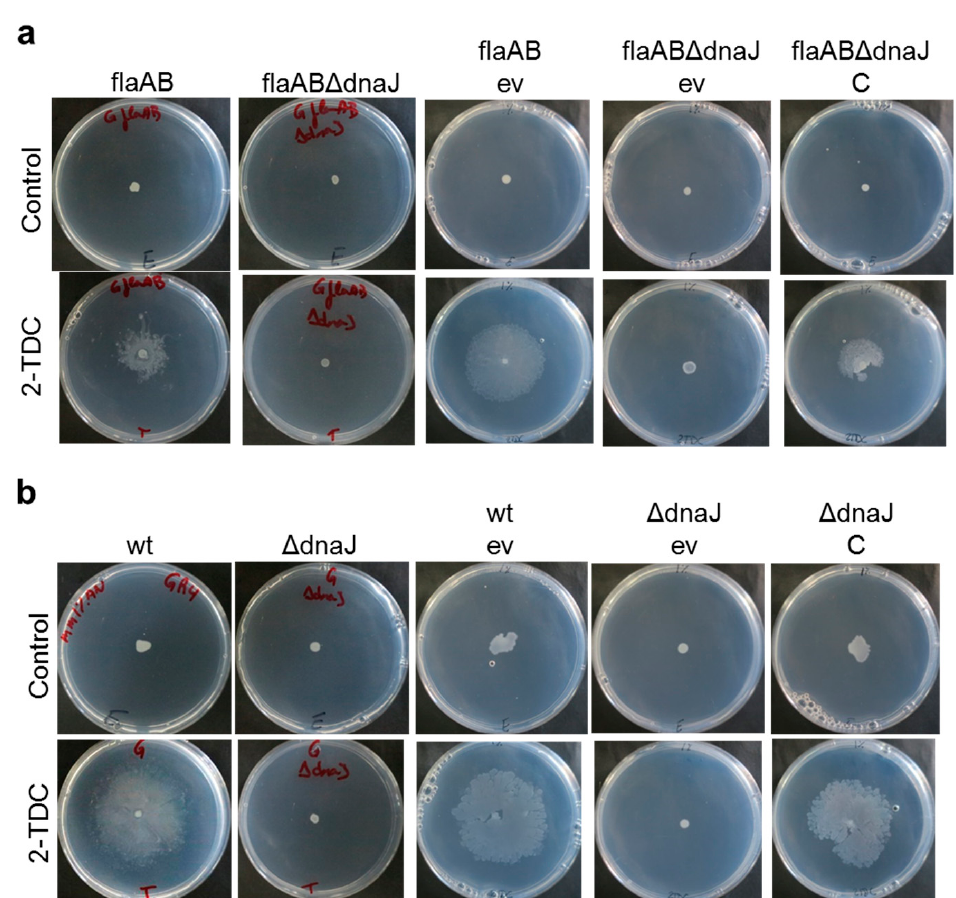
Figure 3. Surface motility exhibited by S. meliloti dnaJ deletion mutants and complemented strains. ( a ) GR4flaAB-derivative strains and ( b ) GR4-derivative strains were assayed on MM (1% agar) in the presence or absence of volatile 2-TDC. About 20 µL of either a solution containing 1 µmol 2-TDC or ethanol (Control) was applied to the lid of the plates just before incubation. flaAB, strain GR4flaAB; wt, strain GR4; Δ dnaJ, strain G Δ dnaJ; ev, empty vector pJB3; and C, complementing plasmid pJ-dnaJ. Representative pictures of the motilities exhibited after 48 h of incubation are shown.